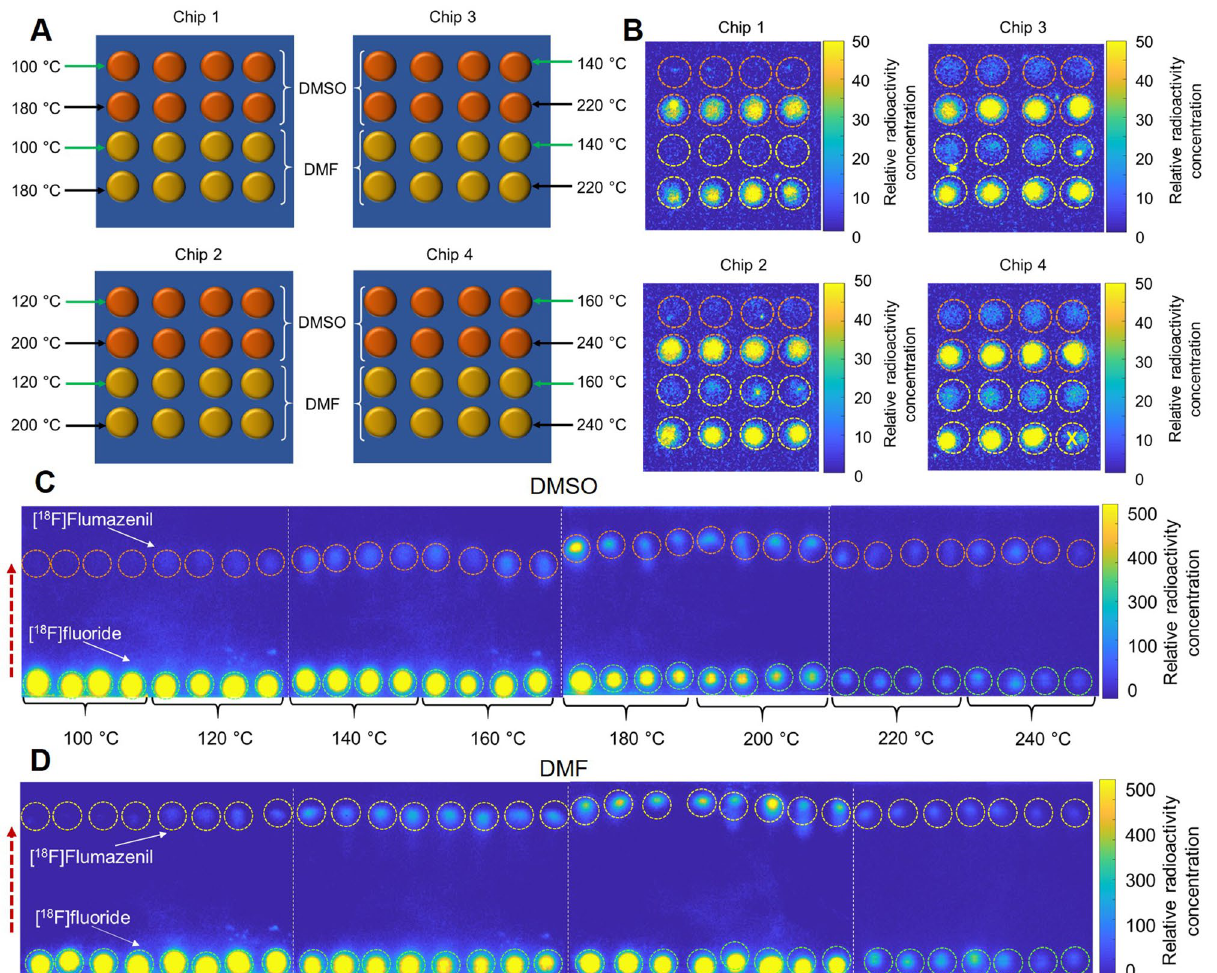
Figure 3. Experimental set up for one batch of experiments that explored the influence of reaction temperature (8 values) and solvent (2 types) for the synthesis of [ 18 F]Flumazenil. ( A ) Assignment of 64 reaction sites. Half of the reaction sites were used first to explore 4 different temperatures in the first set of 32 simultaneous reactions. Then the other half of the sites were used for the remaining 4 temperatures. ( B ) Cerenkov images show the distribution of the residual activity on each chip after collecting the crude products. Radioactivity signal is decay-corrected to a common timepoint for all images. The reaction marked with an “X” was not analyzed (by mistake the precursor droplet was not added to reaction site). ( C ) Cerenkov images of developed TLC plates (each containing 8 samples) for reactions that used DMSO as the reaction solvent. ( D ) Separated crude samples using DMF as the reaction solvent. Dashed circles indicate the ROIs used for analysis. The dashed red arrow indicates the direction of solvent movement during development. White dotted lines represent the boundary of each multi-sample